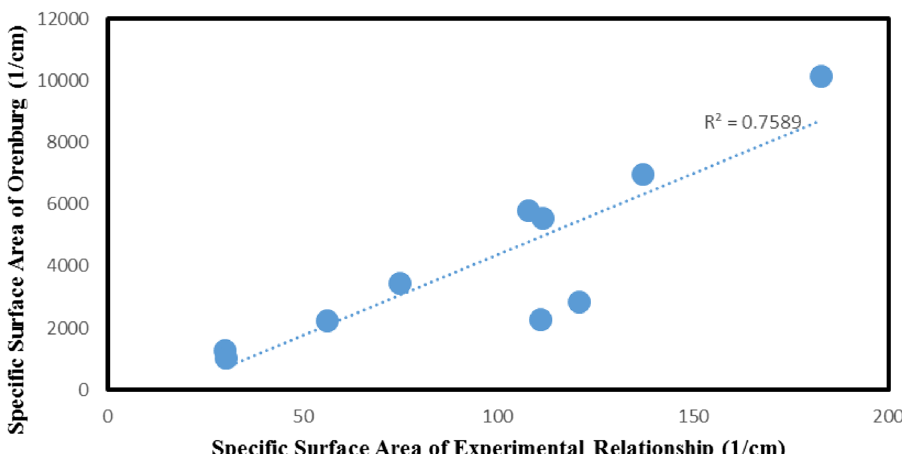
Fig. 14 Specific surface area values of Orenburg data versus Pirson model